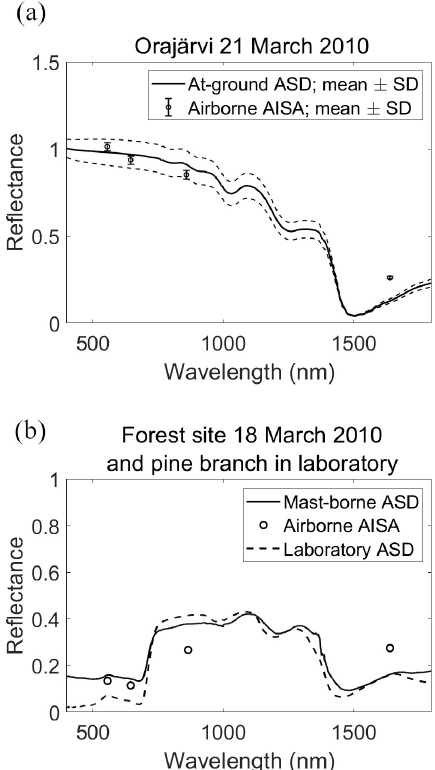
Figure 13. (a) Snow reflectance on lake Orajärvi measured by air- borne (AISA) and portable field platforms. (b) Reflectance of the forest measurement area observed by the mast-borne (spectra) and airborne (four bands) platforms during dry snow conditions and mean of pine branch measurements observed in a